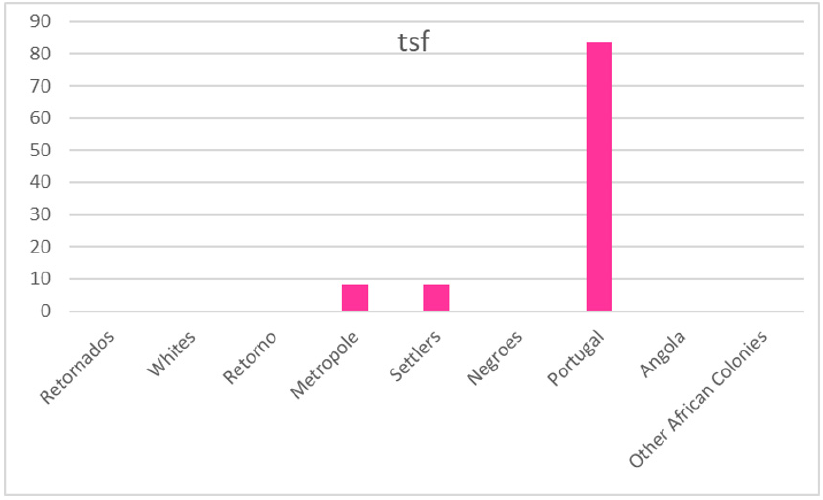
Figure 17. Most frequent words in the text “‘Está muito viva ainda hoje em Portugal.’ Há 60 anos começava a Guerra Colonial”. Source: TSF (2021) [29].